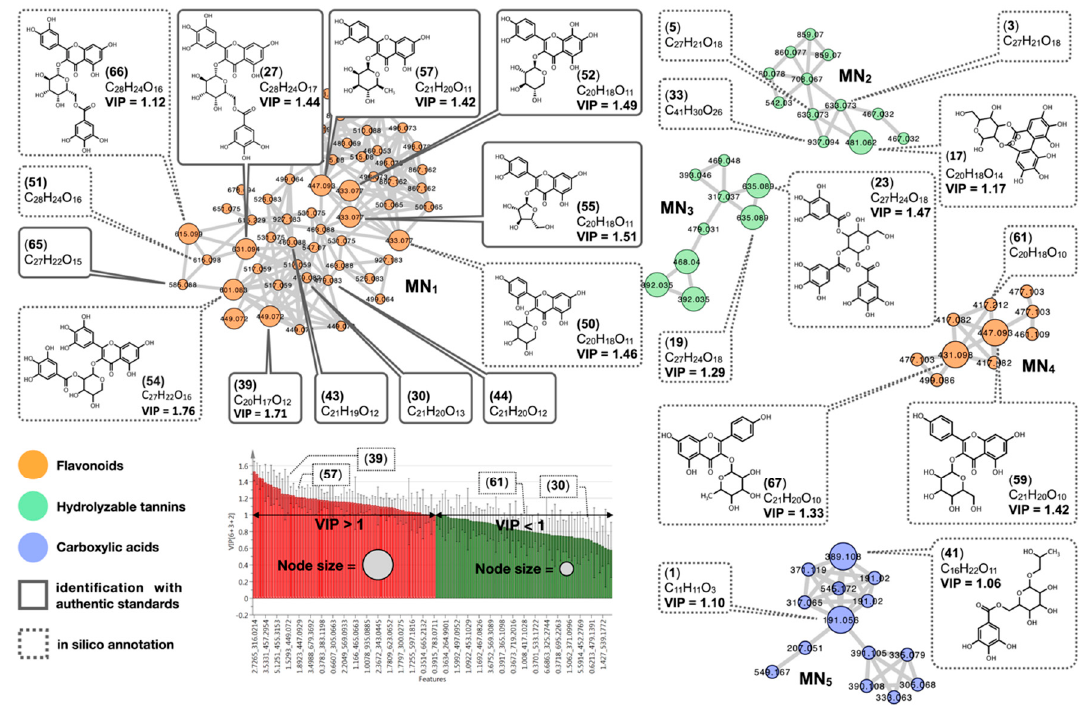
Figure 3. Selected clusters (MN 1 –MN 5 ) from the statistically informed molecular network. VIP values greater than 1 (represented in red in the VIP plot) from the O2PLS model were integrated into the molecular network and can be visualized through the node size. Larger nodes indicate features with VIP values greater than 1. Dotted line boxes indicate putatively annotated compounds (ISDB-DNP in silico annotations), and full lines indicate dereplicated compounds for which identity was confirmed by comparing the spectroscopic data with compounds isolated from Myrcia bella . Green, orange, or purple colors indicate the chemical classes of the compounds. Flavonoid, tannin, and carboxylic acid chemical class clusters with representative structures are depicted.